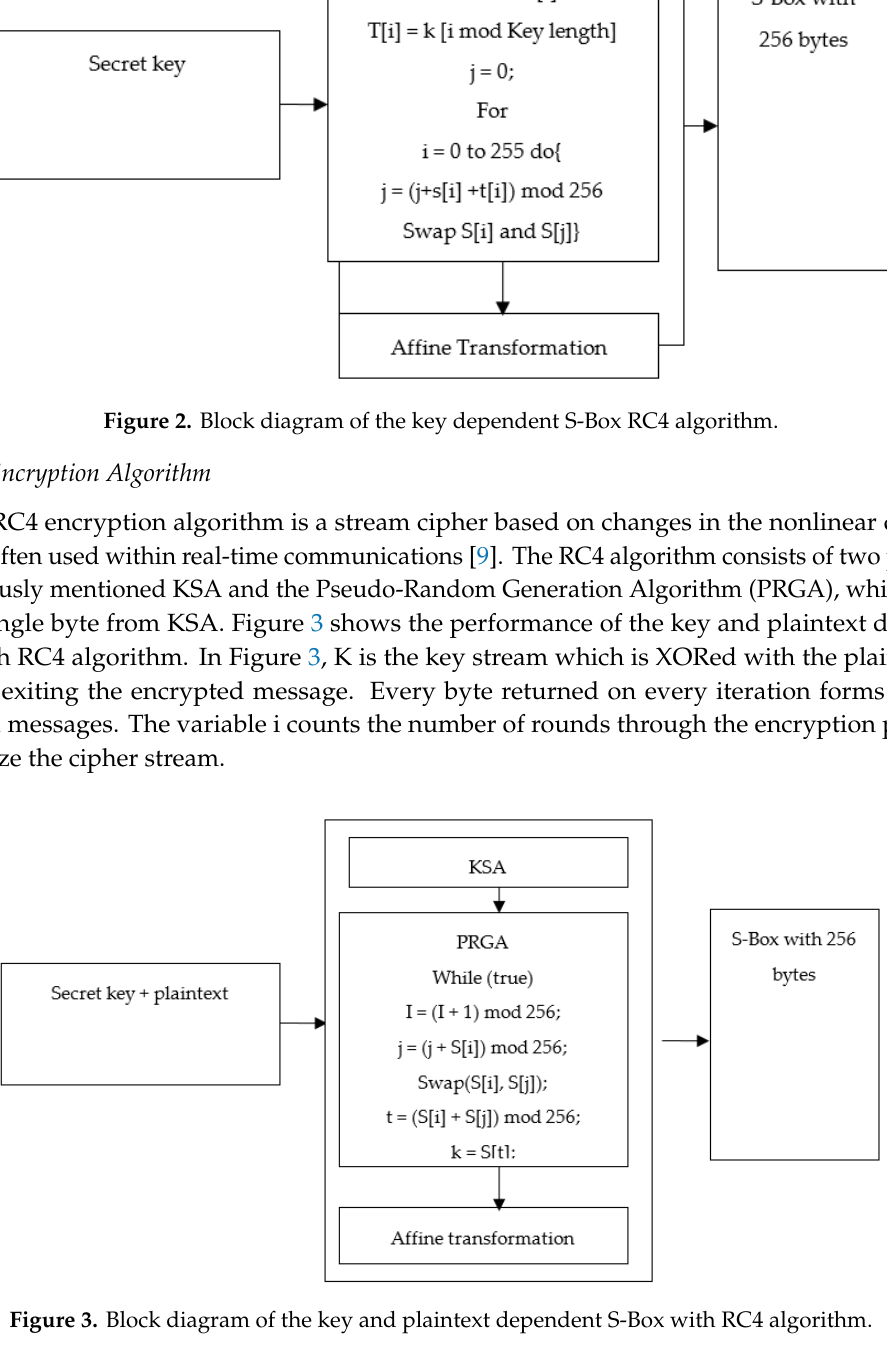
Table 1. Dynamic S-Box with the key “FEDCBA9876543210”.